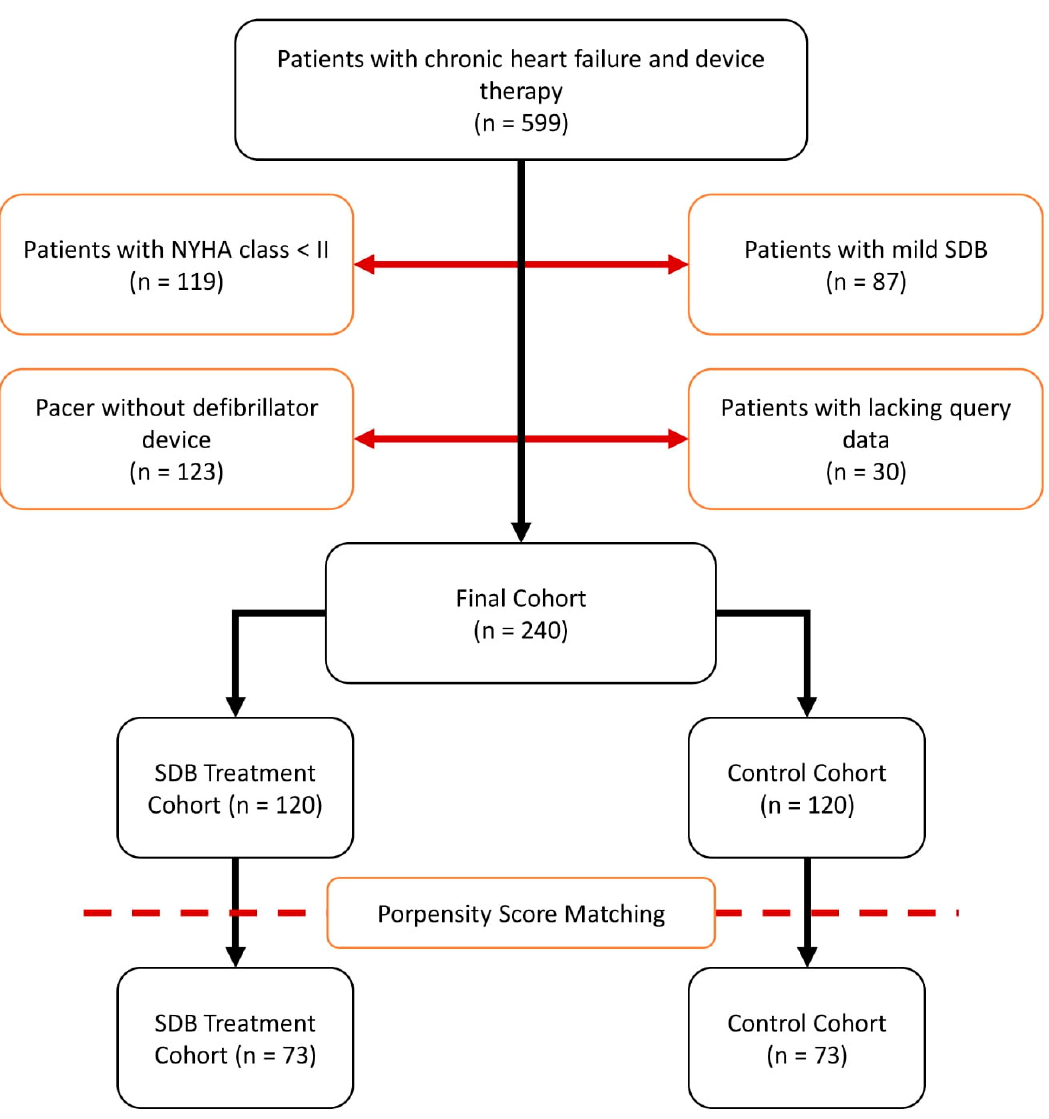
Figure 1. Patient Recruitment and Propensity Score